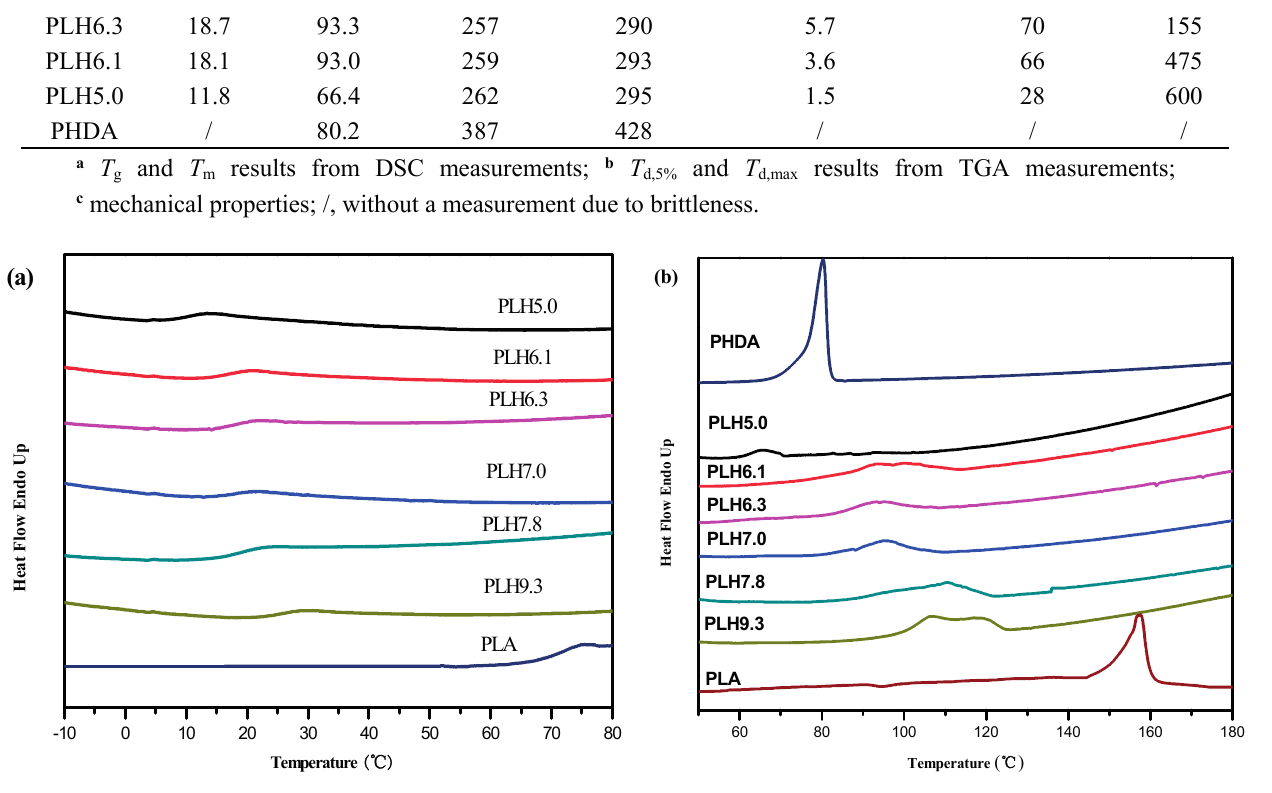
Figure 2. DSC curves of the PLH copolymers: ( a ) T g from the second heating scan and ( b ) T m from the first heating